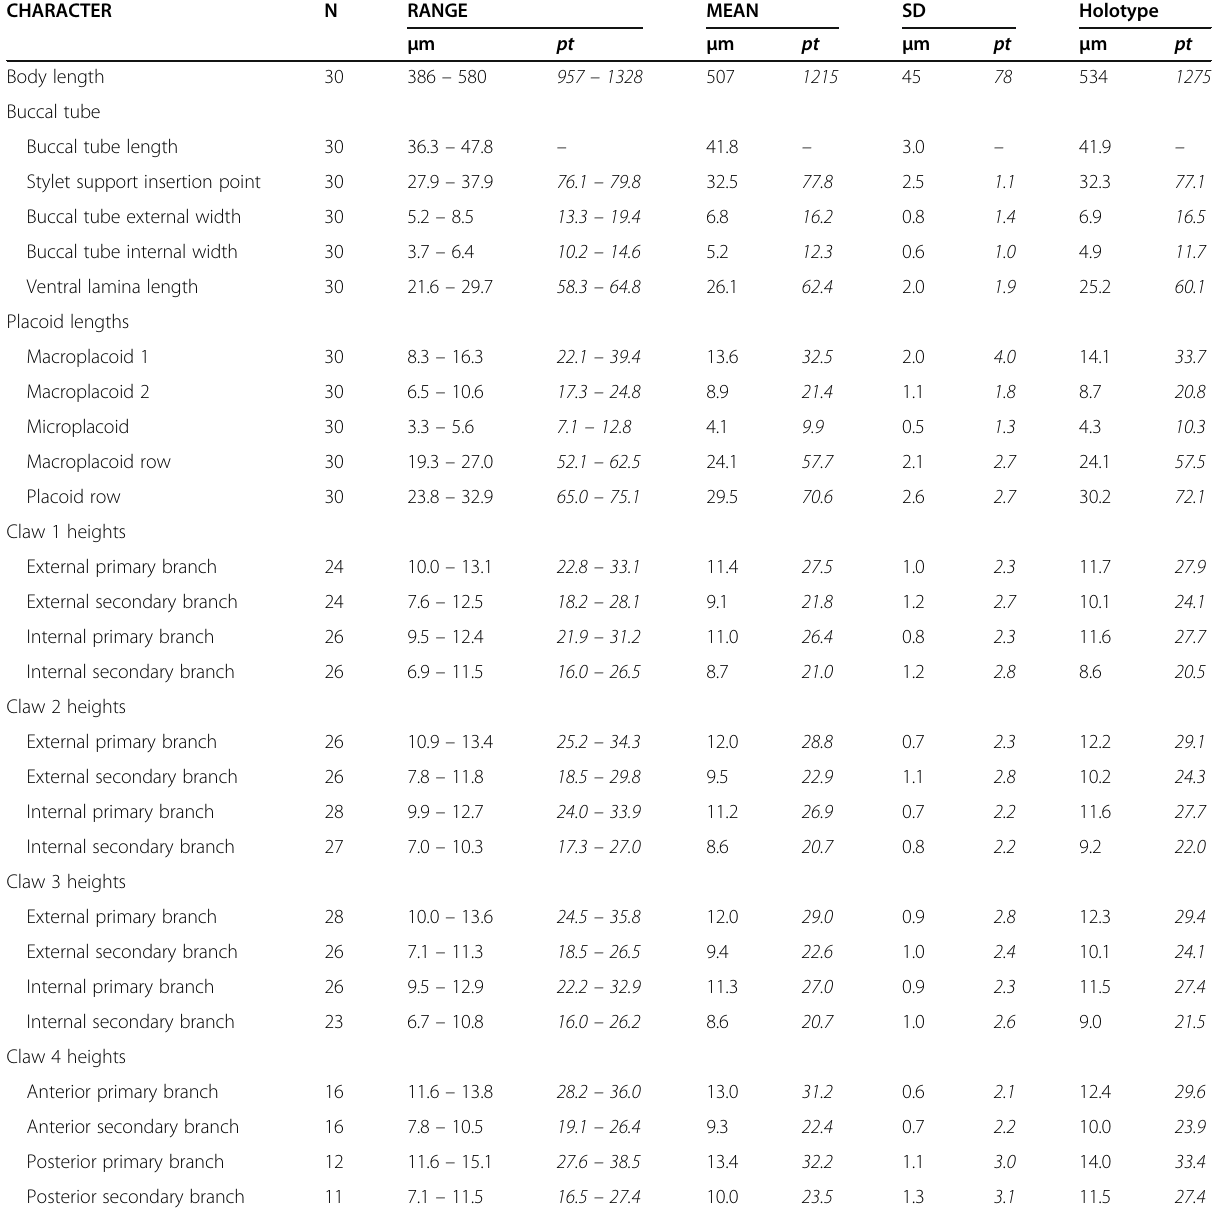
Table 8 Measurements [in μ m] of selected morphological structures of individuals of Macrobiotus pseudopallarii sp. nov. from Montenegro (ME.007) mounted in Hoyer ’ s medium (N – number of specimens/structures measured, RANGE refers to the smallest and the largest structures among all measured specimens; SD – standard